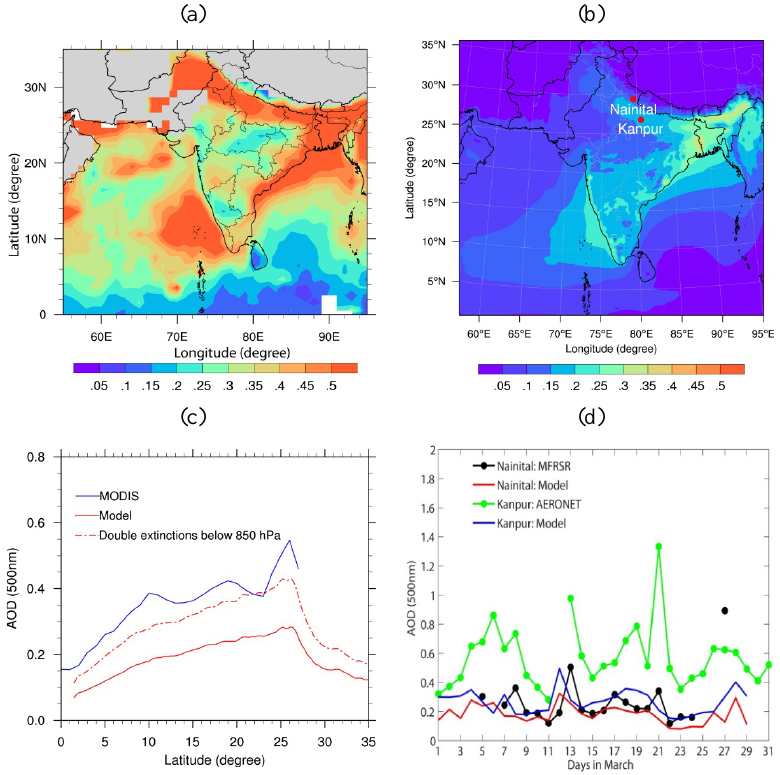
Figure 1. For March 2012: (a) MODIS-retrieved and (b) simulated monthly mean AOD distributions over South Asia. The locations of Nainital and Kanpur sites are indicated by red dots. (c) Latitudinal variations in AOD averaged for 60–95 ◦ E from the model control run (red solid), sensitivity runs (red dotted dash), and MODIS retrievals (blue). North of 27 ◦ N, more than two-thirds of the MODIS AODs are missing (data not shown). (d) Comparison of simulated and observed daily mean AOD at Nainital and